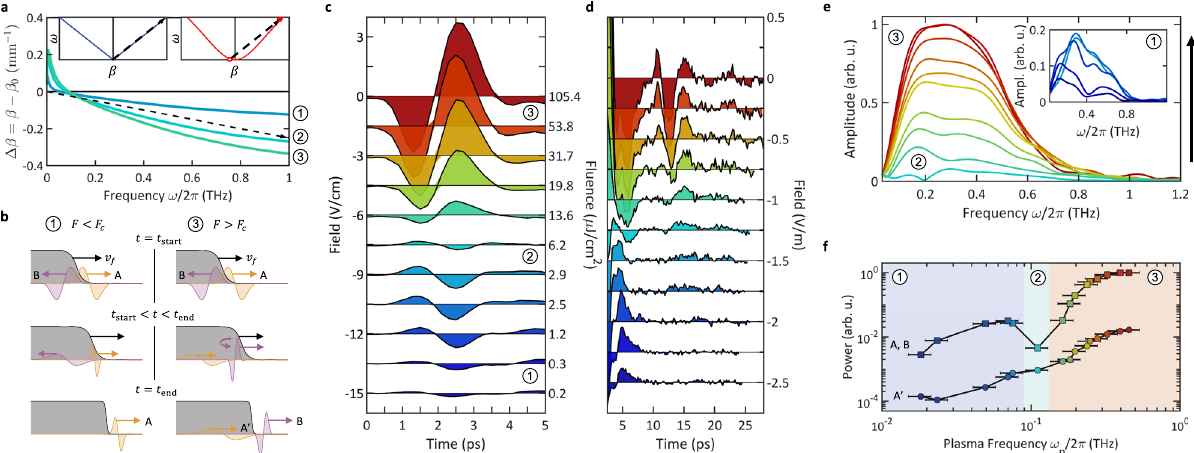
Fig. 3 Time-reversing a THz pulse through front-induced transitions with a super-luminal moving front. a Plasma dispersion relation β projected onto the unexcited transverse electro-magnetic (TEM) mode wavenumber β 0 (horizontal black line) for excitation conditions: (1 — light blue line) ω 2 / β 2 < v f , (2 — cyan line) ω 2 / β 2 = v f and (3 — green line) ω 2 / β 2 > v f . The dashed line is the front velocity v f = 1.0035 c / n Si . The vacuum speed of light is c and the refractive index in silicon is n Si . The left inset shows that only forward intra-band scattering is possible at weak excitation (blue line), whereas the right inset shows that a time-reversal scattering event ( − β 1 → β 2 , empty dot to solid circle) becomes phase matched for highly photoexcited (red line) dispersion conditions. b Real space pictures that follow the evolution of initially-forward (pulse A) and initially-backward (pulse B) propagating THz waves for plasma